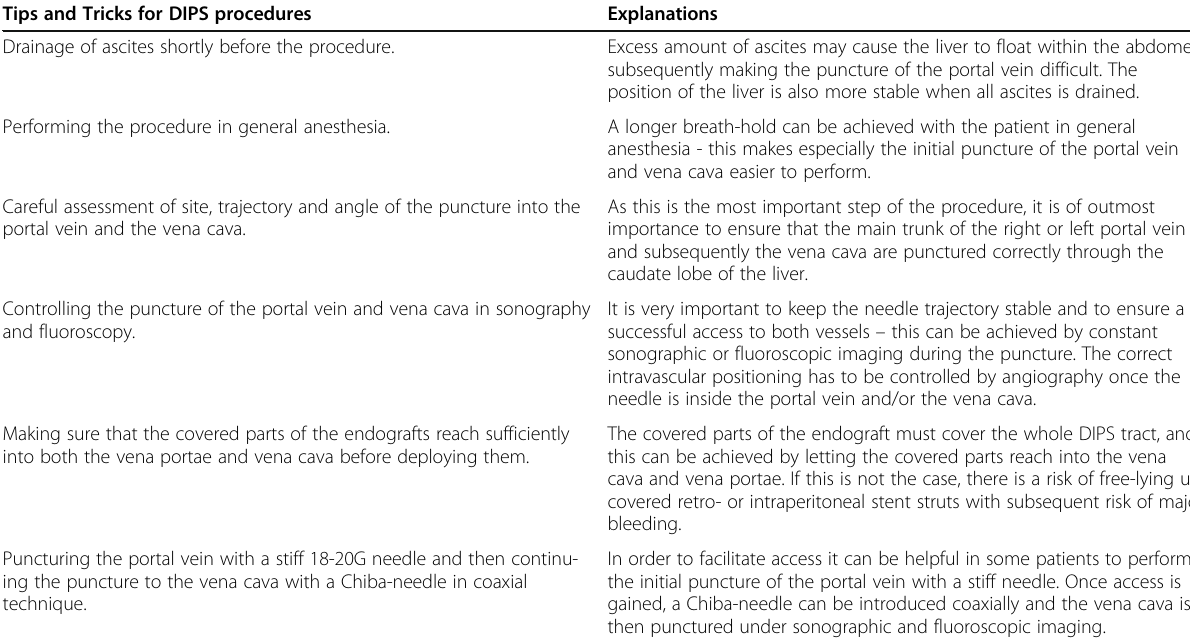
Table 1 Tips and Tricks for percutaneous ultrasound-guided DIPS